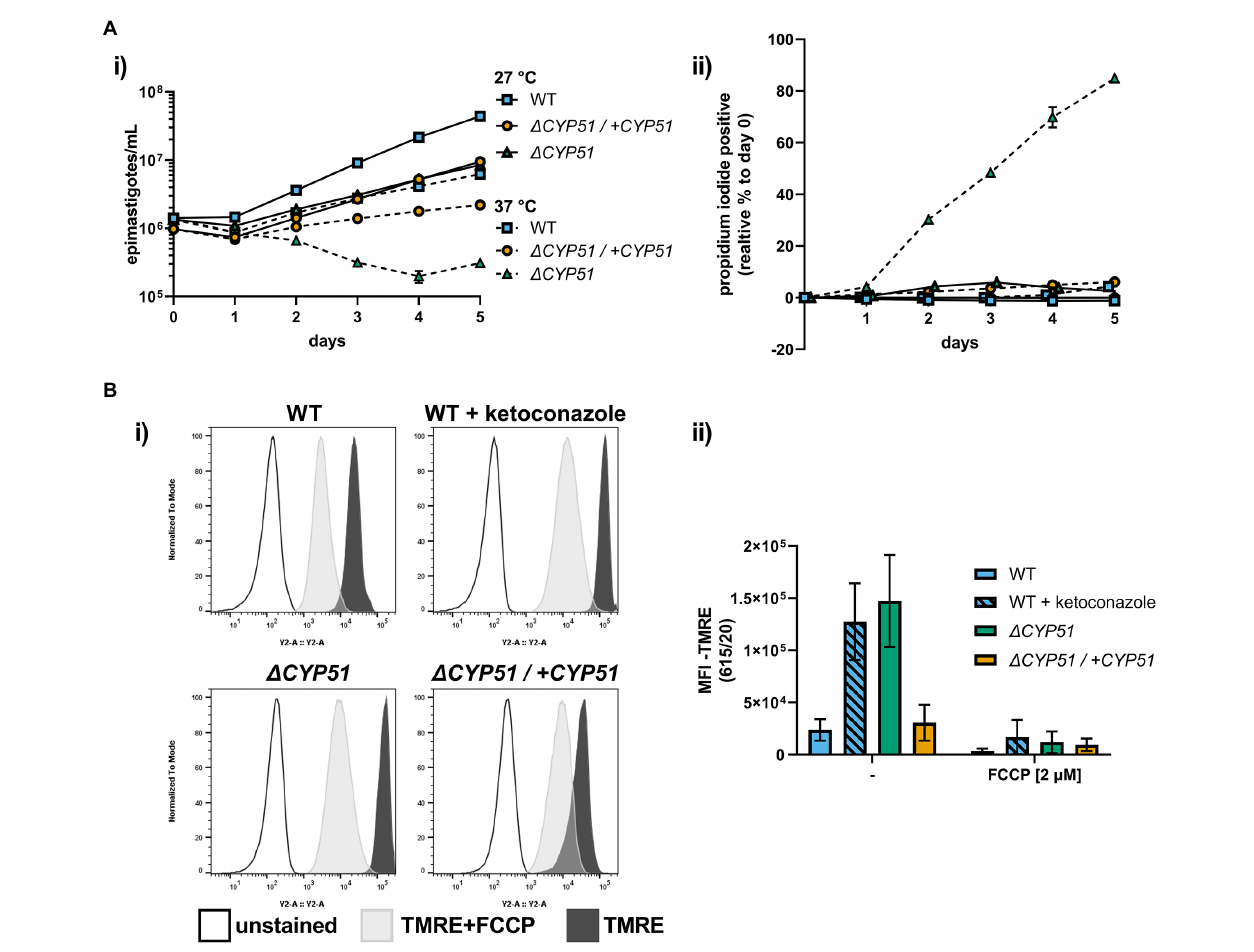
FIGURE 4 | (A) (i) Growth and (ii) membrane integrity of epimastigotes assessed daily during continual exposure to either 27 ° C or 37 ° C (n = 3), mean ± SD shown. (B) (i) Flow cytometry histograms of parasite fluorescence in the Y2 (615/20) channel. Unstained controls are shown along with TMRE stained parasites. (ii) Mean fluorescence intensity (MFI) in the Y2 channel with and without pre-treatment of parasites with FCCP, ±SD shown. Parasite line or ketoconazole treatment, FCCP treatment and interaction have p < 0.001 by two-way ANOVA; all multiple pairwise comparisons compared to WT are significant after Bonferroni